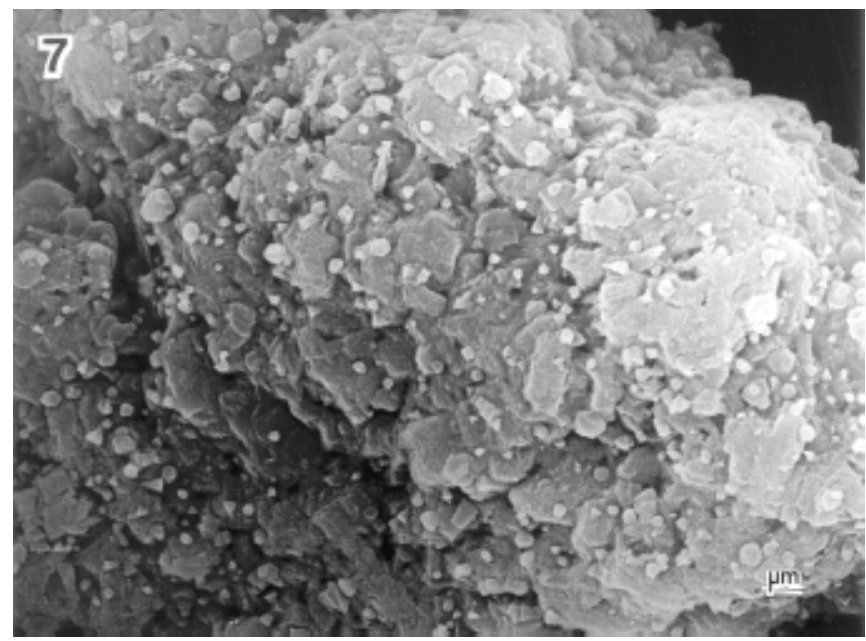
Fig. 7 – SEM of an agglomerate after being heated at 700 ◦